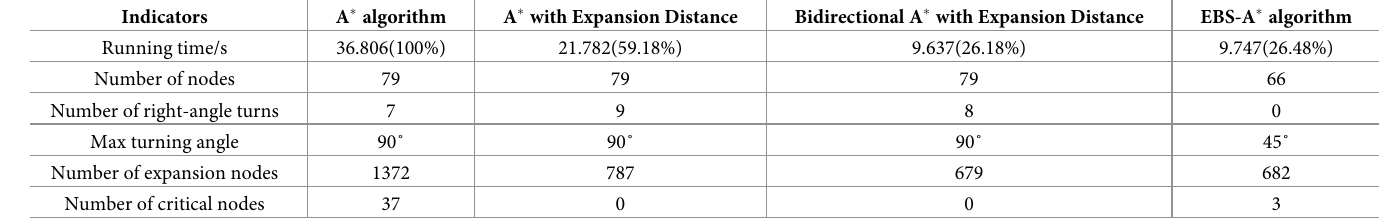
Table 1. Simulation results of four algorithms on a 50 × 50 map.